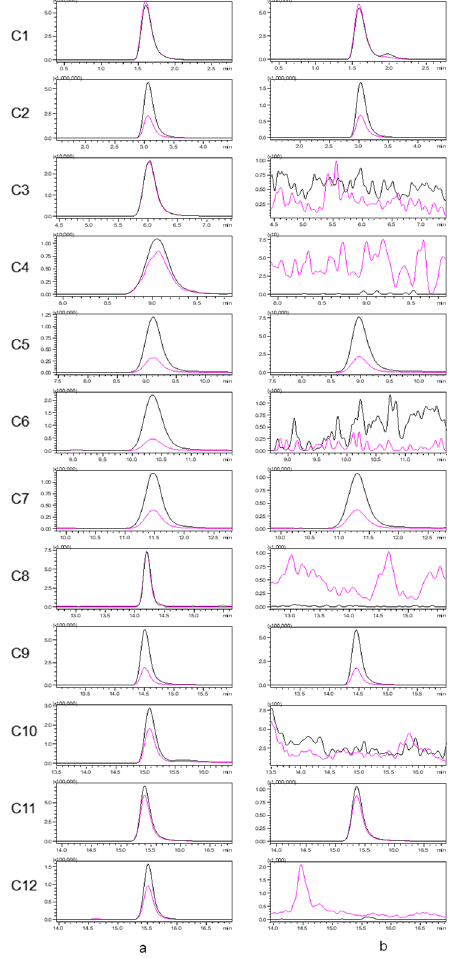
Figure 1. Typical multiple reaction monitoring (MRM) chromatograms for a mixed standard solution ( a ) and a sample of Houttuyniae herba ( b ). [The quantitative ion pairs: C1( m / z 282.0 > 251.1); C2( m / z 282.0 > 265.1); C3( m / z 344.9 > 282.0); C4( m / z 374.9 > 314.1); C5( m / z 266.0 > 251.1); C6( m / z 374.9 > 312.0); C7( m / z 266.0 > 251.1); C8( m / z 329.0 > 268.1); C9( m / z 279.9 > 264.1); C10( m / z 294.0 > 278.9); C11( m / z 322.0 > 306.0); C12( m / z 359.0 > 298.1)].